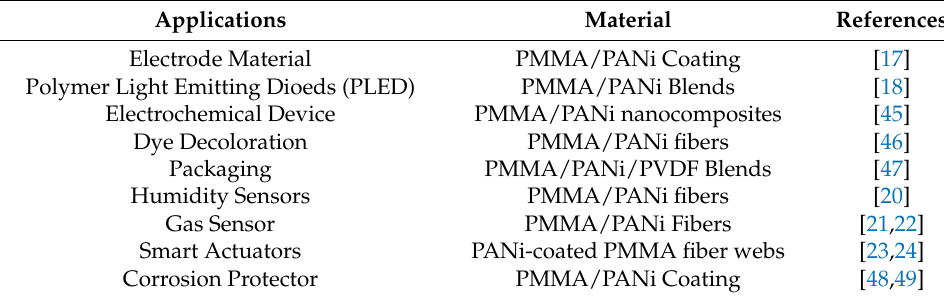
Table 1. Potential applications of PMMA/PANi blends and